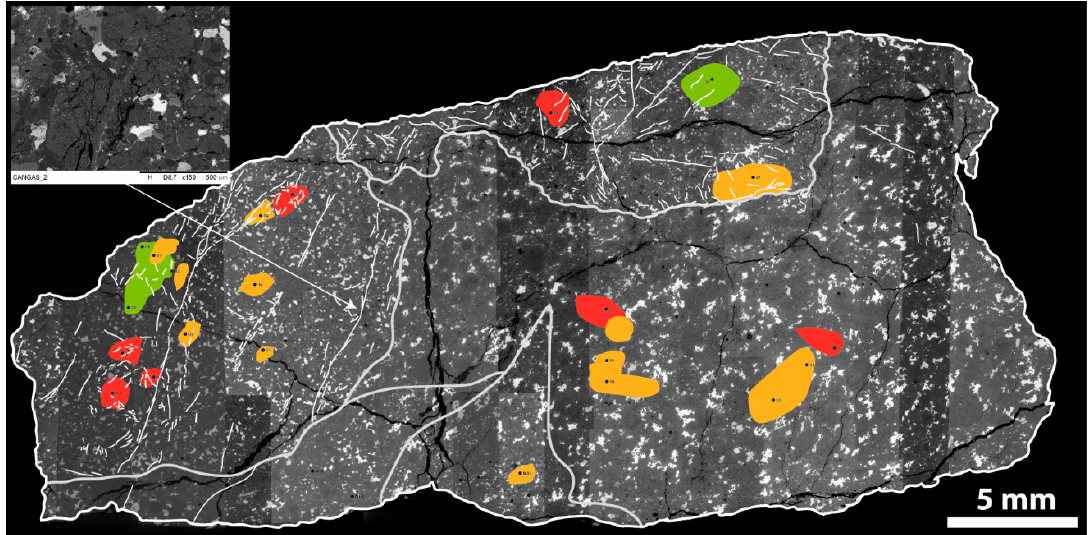
Figure 9. Interpretative scheme of the analyzed probe (same as Figure 1), including clast limits and main shock-melted fractures (e.g., detailed image). An approximate pressure effect deduced from the Raman and FTIR peak positions observed in the phosphates and maskelynite have been included (green, relatively low pressure; orange, intermediate; red, relatively high pressure).